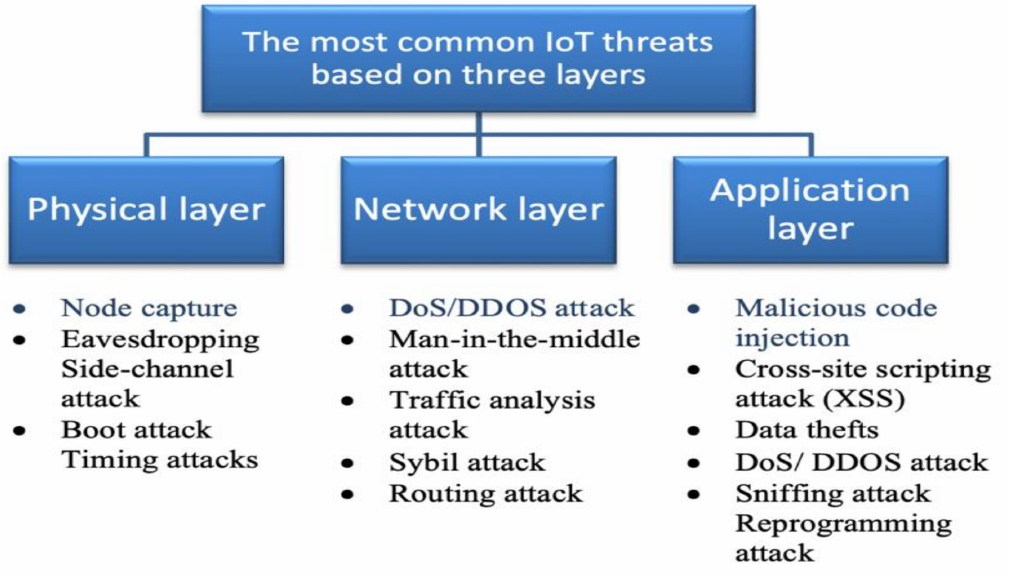
Figure 9. Summary of the most common threats on IoT based on three layers architecture. The common technologies used to address IoT threats according to analyzed studies are: blockchain, machine learning, fog computing, and edge computing. As shown in Figure 10, the most frequently suggested technology is